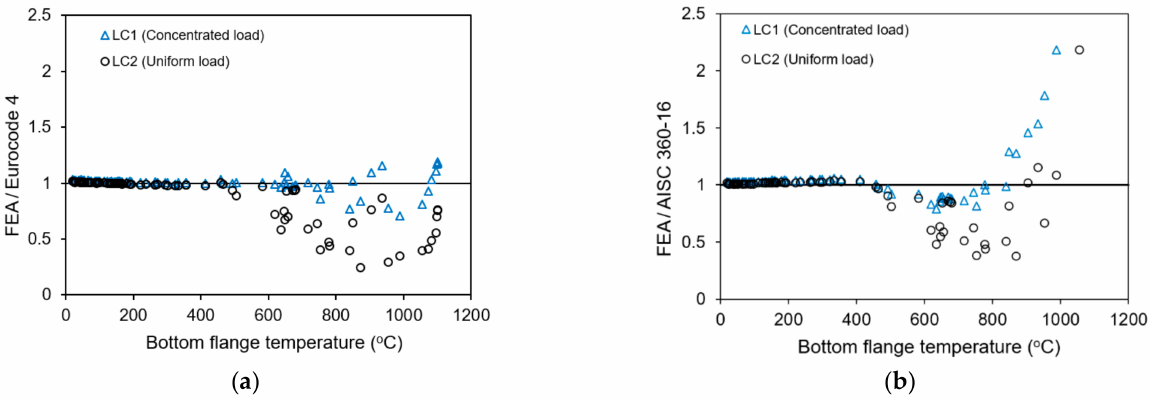
Figure 15. Comparison between FEA results and design codes: ( a ) Eurocode 4, Part 1-2 [31]; ( b ) AISC